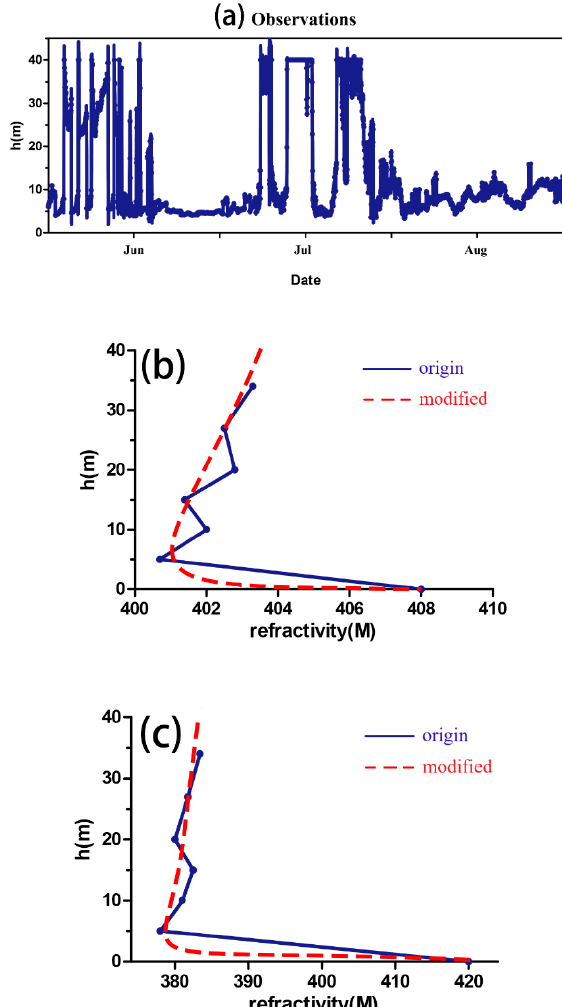
Figure 11. Observation data of the evaporation duct from June to September 2018 in the SCS (9°37 ′ N, 112°58 ′ E): ( a ) variation of evaporation duct height over a full BSISO cycle in the summer of 2018; ( b , c ) calculated refractivity profiles based on observations of the typical BSISO positive (5–10 June) and negative (5–10 July) phases during